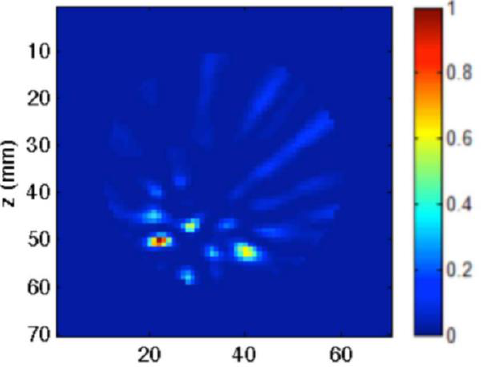
Figure 27. Microwave radar system for breast cancer detection developed by Porter et al. [83]. ( a ) A schematic of the microwave radar system setup. ( b ) A photograph showing the wearable prototype system. The top left photograph shows the connectorised monopole antenna. The top right photograph shows the antenna array inside the bra-cup with antennas’ numbers marked. The bottom photograph shows the outside of the bra and the cables that connect to the antennas. Reprinted with permission from [83].